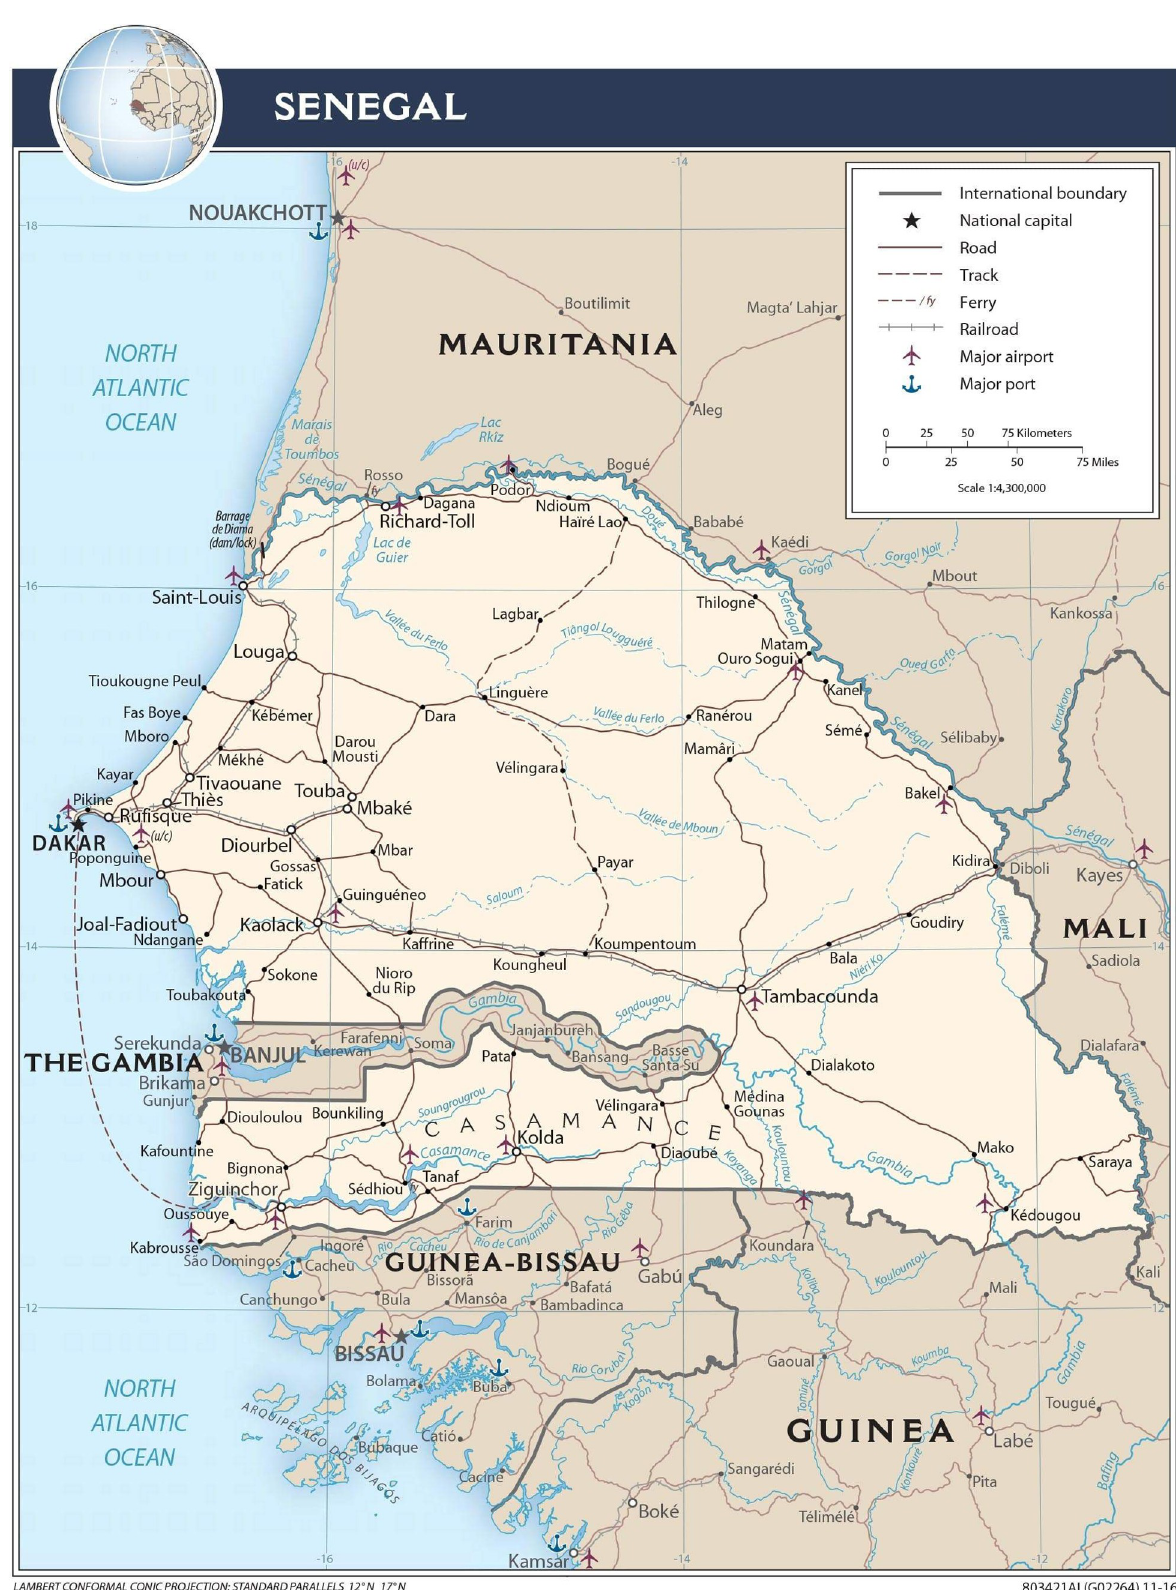
Fig 1. Map of Senegal showing the study sites.